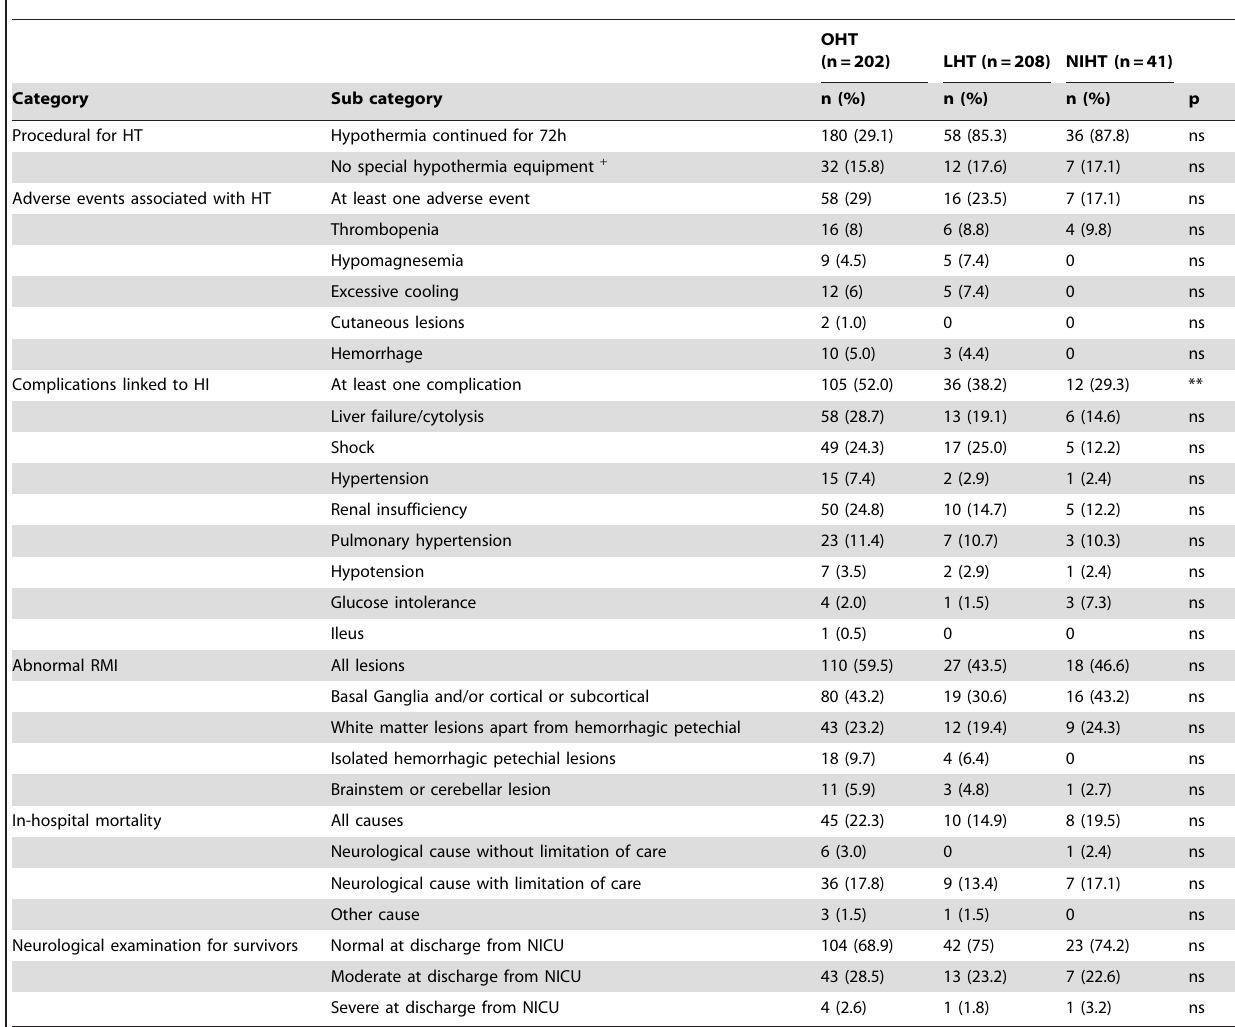
Table 4. Characteristics of HT, adverse events, complications and short-term outcomes according to the different HT